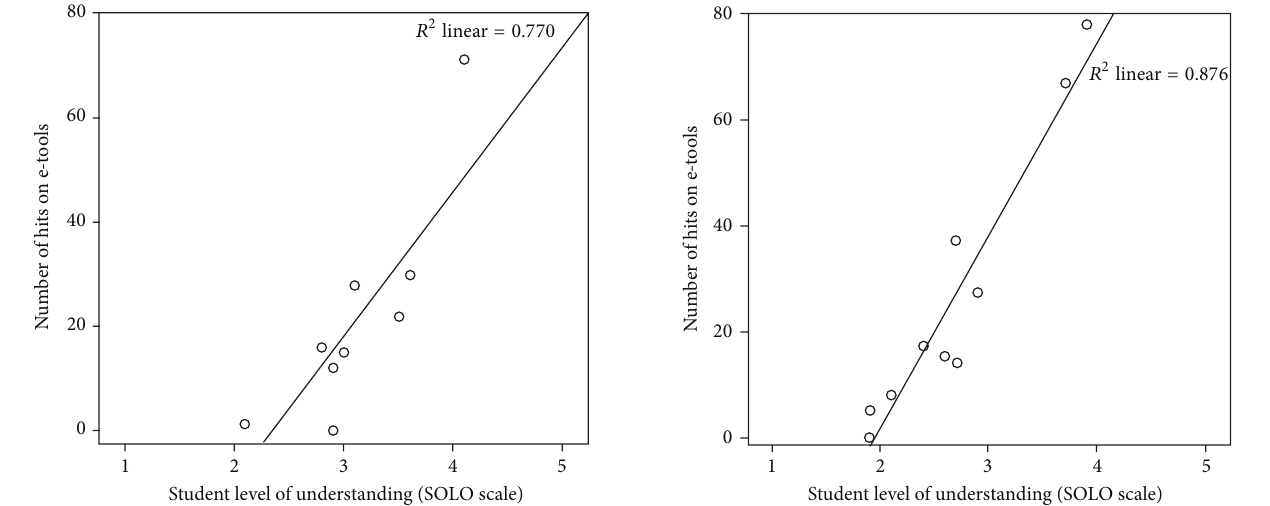
Figure 1: Scatterplots showing the number of hits on e-learning tools and student level of understanding in the related questions for the course 3024PHM (semester one, 2012). Student level of understanding is categorised according to SOLO taxonomy into five levels: (1) prestructural, (2) unistructural, (3) multistructural, (4) relational, and (5) extended abstract.